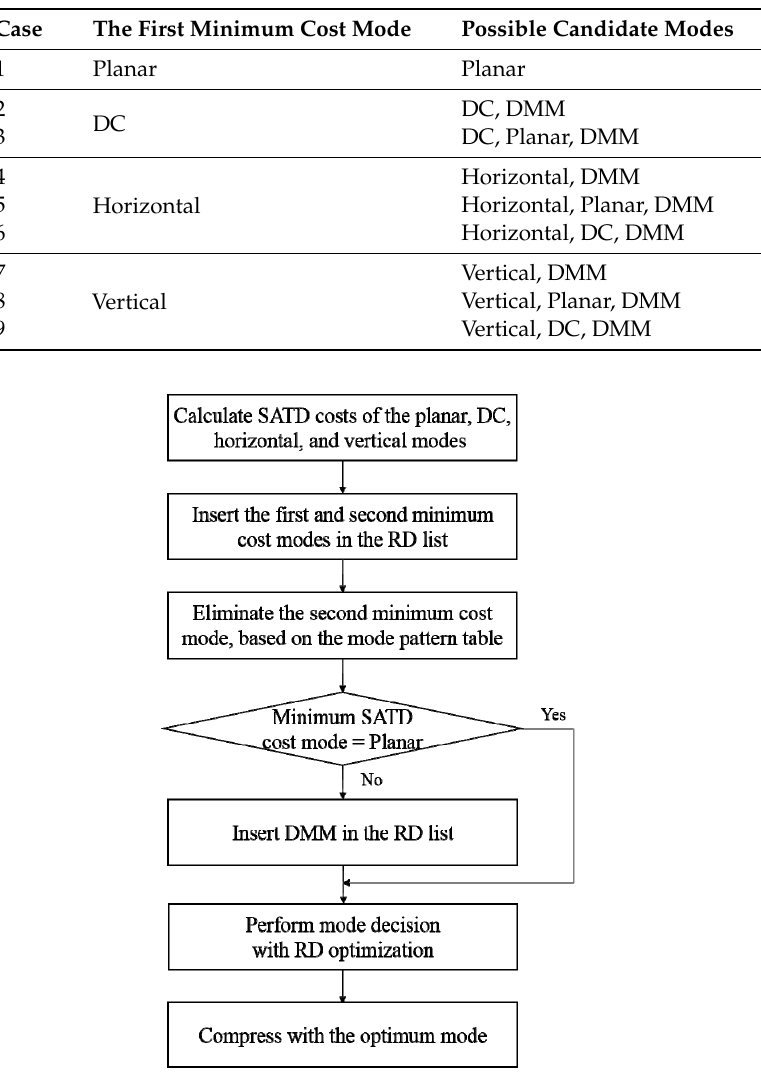
Figure 7. Flowchart of the proposed depth intra mode decision using the mode pattern table.